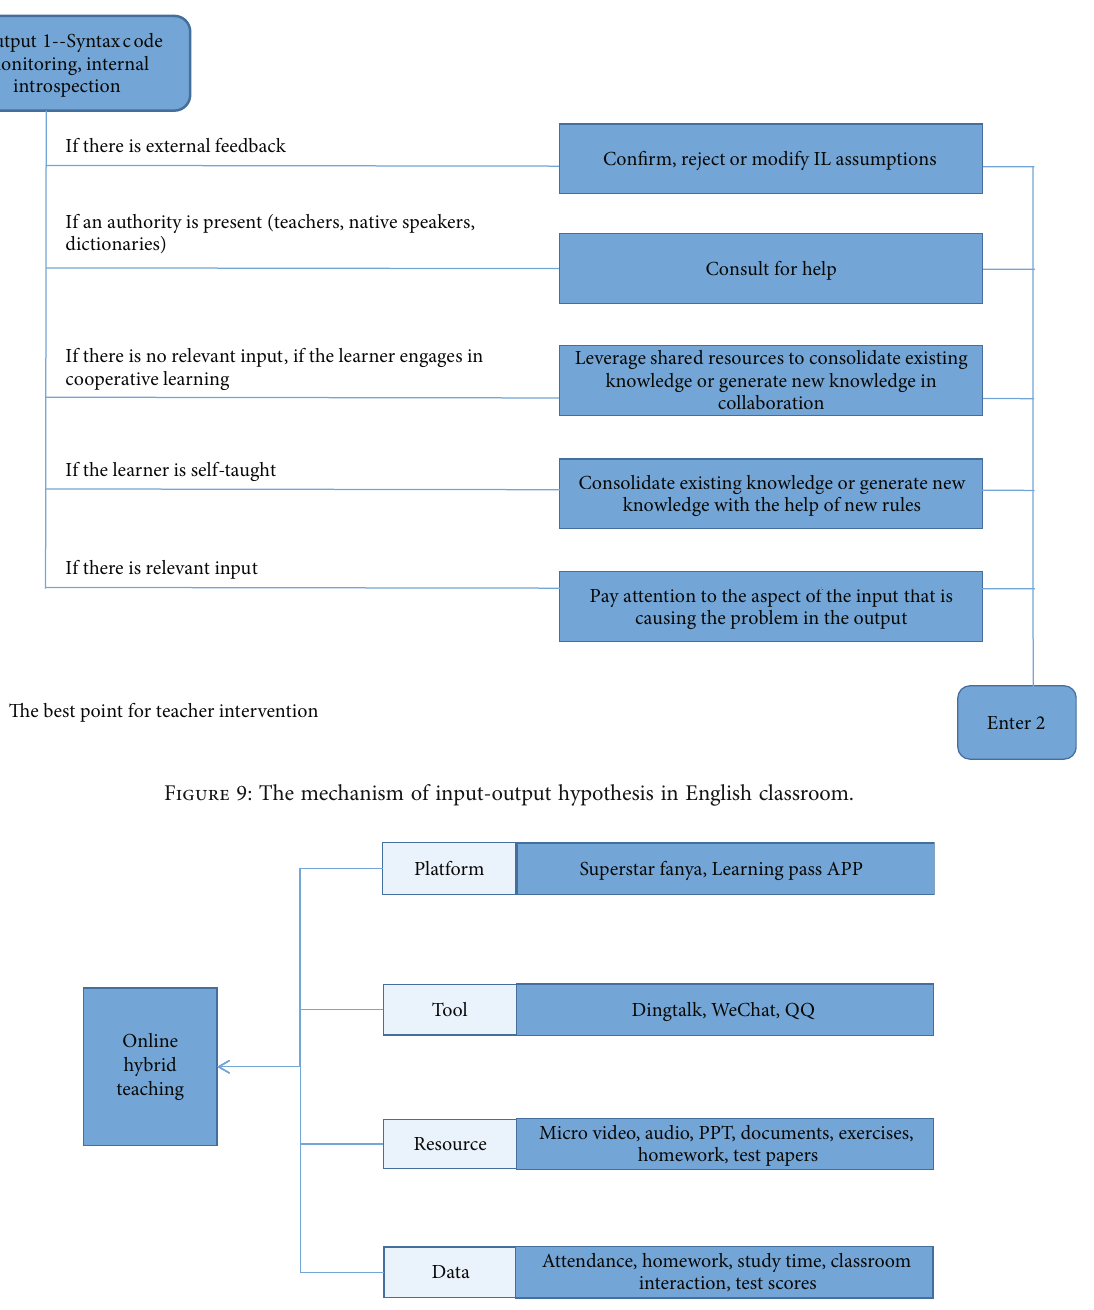
Figure 10: Online mixed multiple teaching